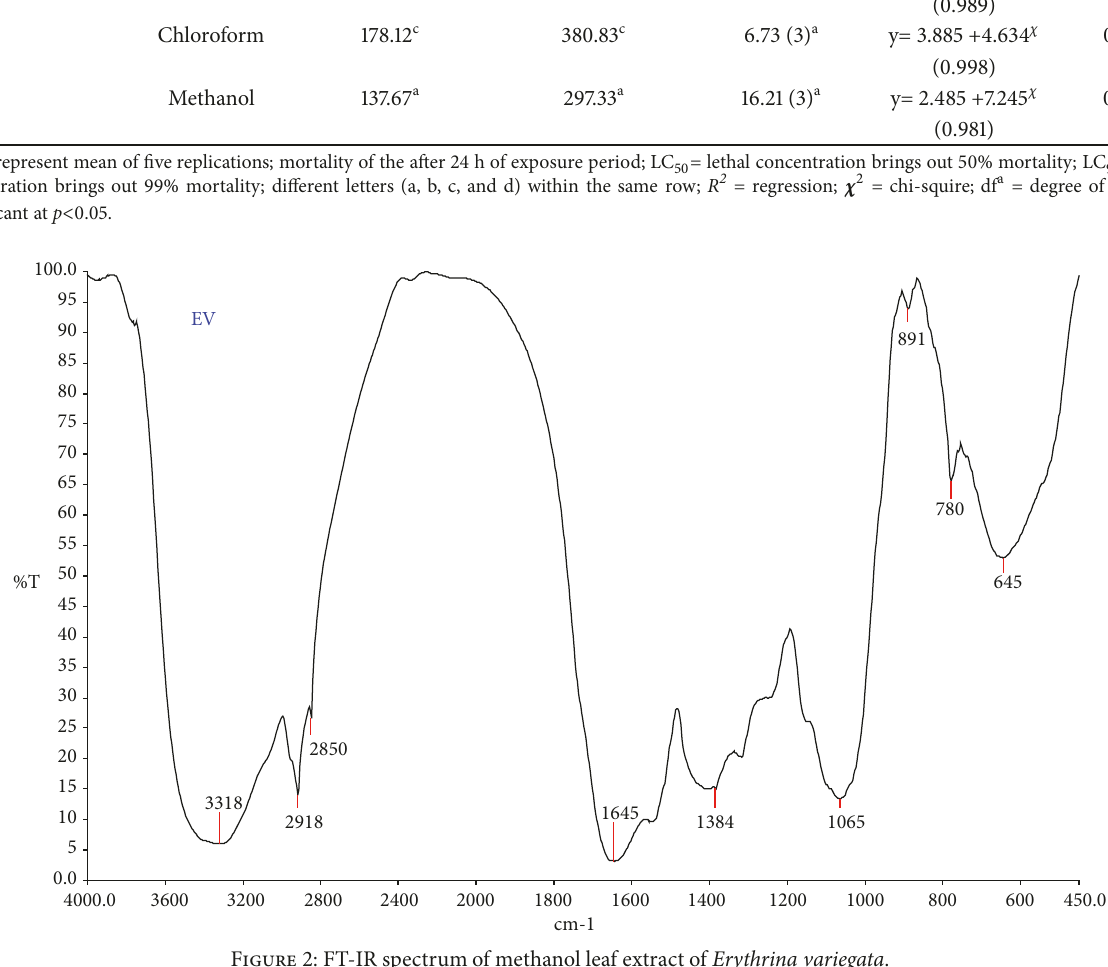
Figure 2: FT-IR spectrum of methanol leaf extract of Erythrina variegata